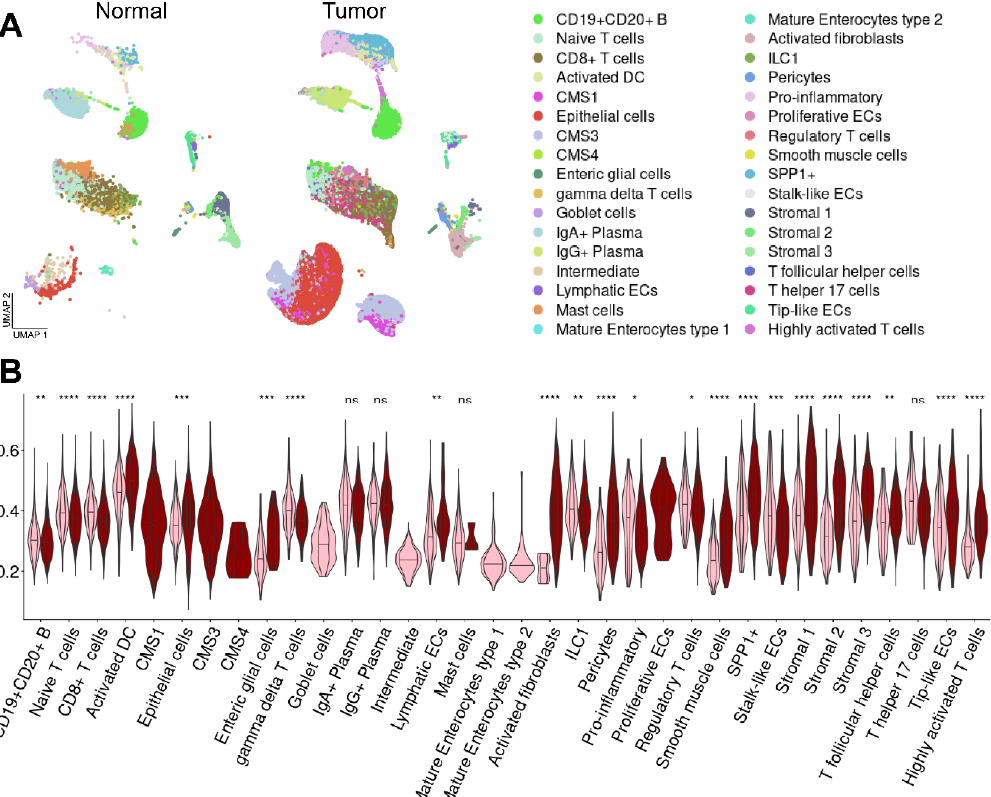
Figure 4. Enrichment of CD risk genes in UC-associated neoplasia and sporadic CRC. ( A ) Genes upregulated in UC and CD regions were obtained from a study by Peloquin et al. [10] and overlapped. ( B ) Microarray analysis revealed only a slight upregulation of CD risk genes in UC. * p < 0.05, ** p < 0.01, *** p < 0.001, **** p < 0.0001.